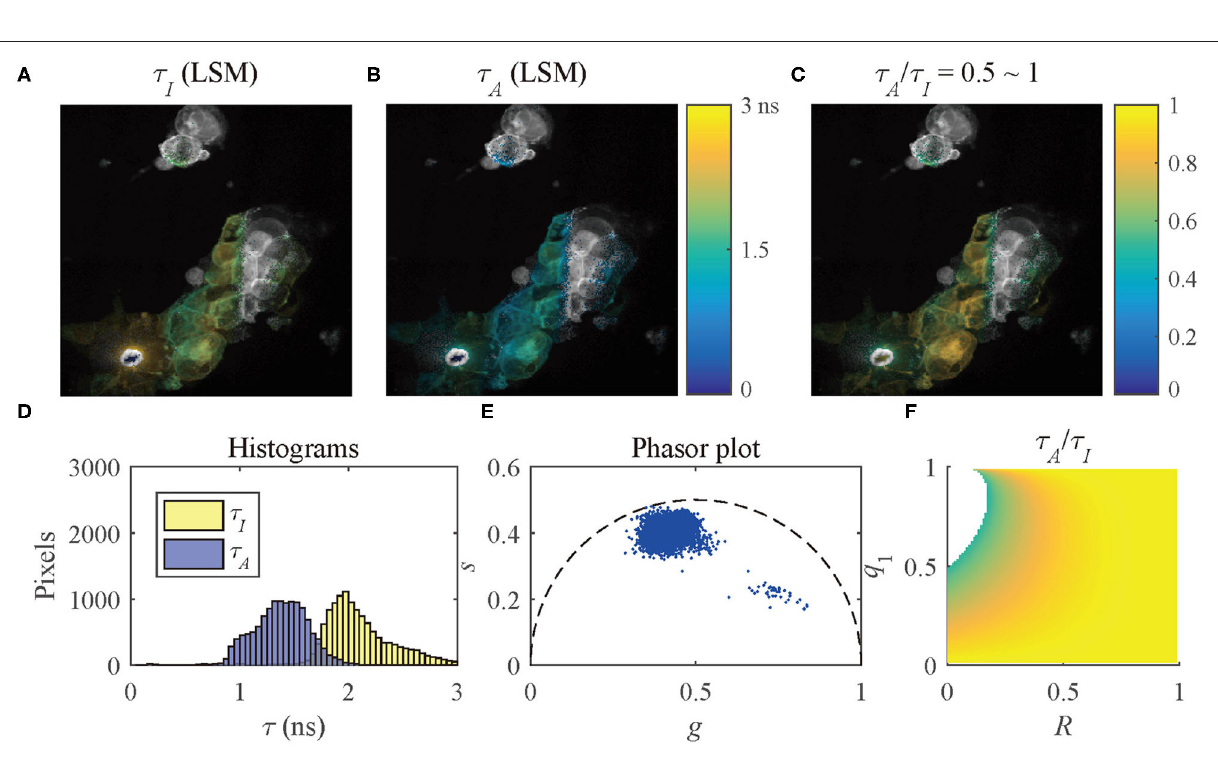
FIGURE 11 | (A) τ I -intensity image, (B) τ A -intensity image evaluated by LSM-2, (C) τ A /τ I ratio image, (D) histograms of τ I (yellow) and τ A (blue), (E) phasor plot, and (F) distribution of τ A /τ I of the selected pixels in (C) with τ A /τ I